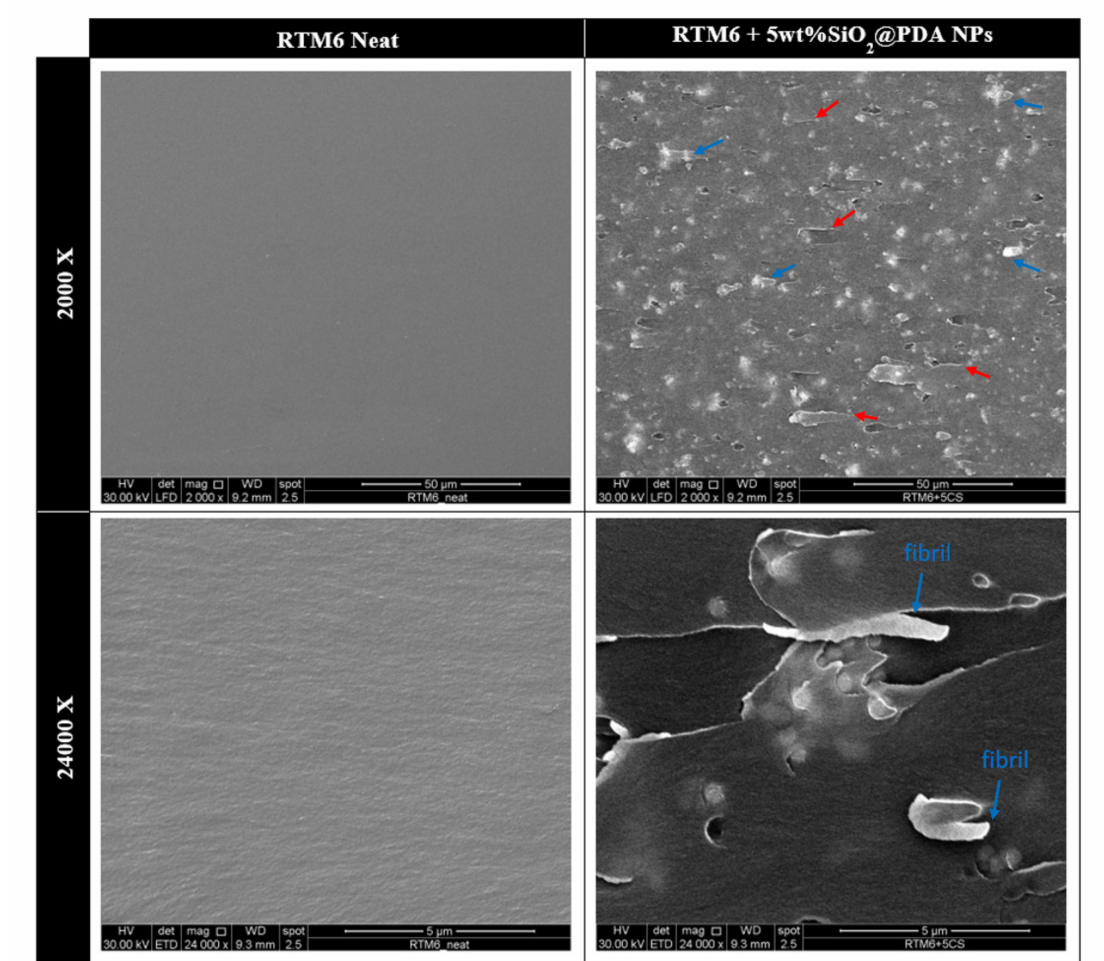
Figure 11. SEM images of neat epoxy and 5 wt% SiO 2 @PDA loaded system fracture surfaces labeled according to row and column